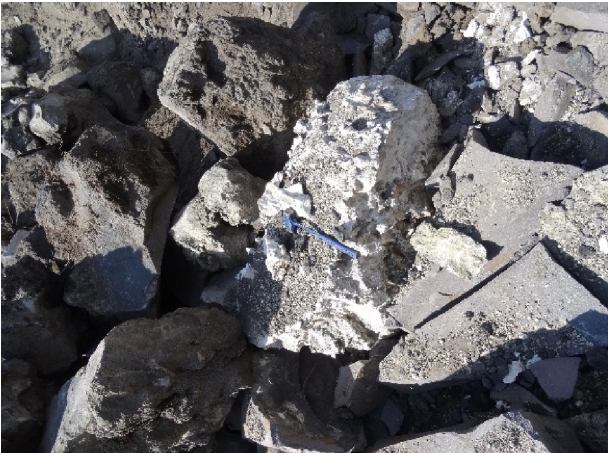
Figure B.2: Photograph of ∼ 1 × 2 m anhydrite xeno- lith POP-97-m2 found within a quarry of the Nealticán lava. The exterior of the anhydrite boulder looks rounded and corroded, whereas its interior is very fresh and appears to be una ff ected by interaction with the